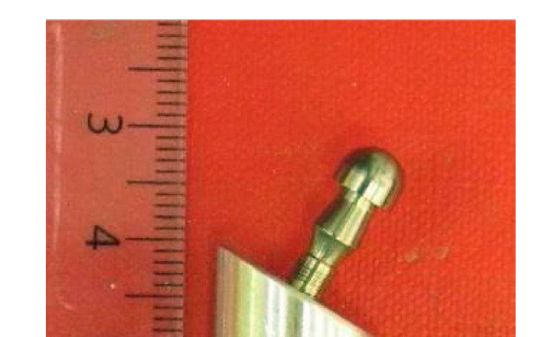
Figure 2. Loading scheme.